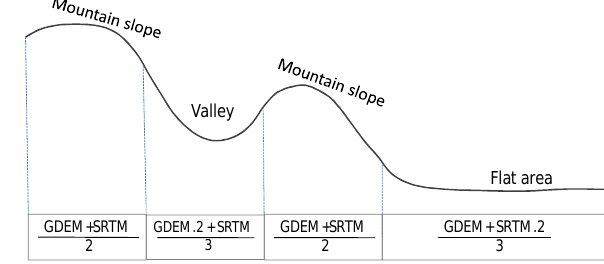
Figure 11. Weighted averaging used to fuse global DEMs.